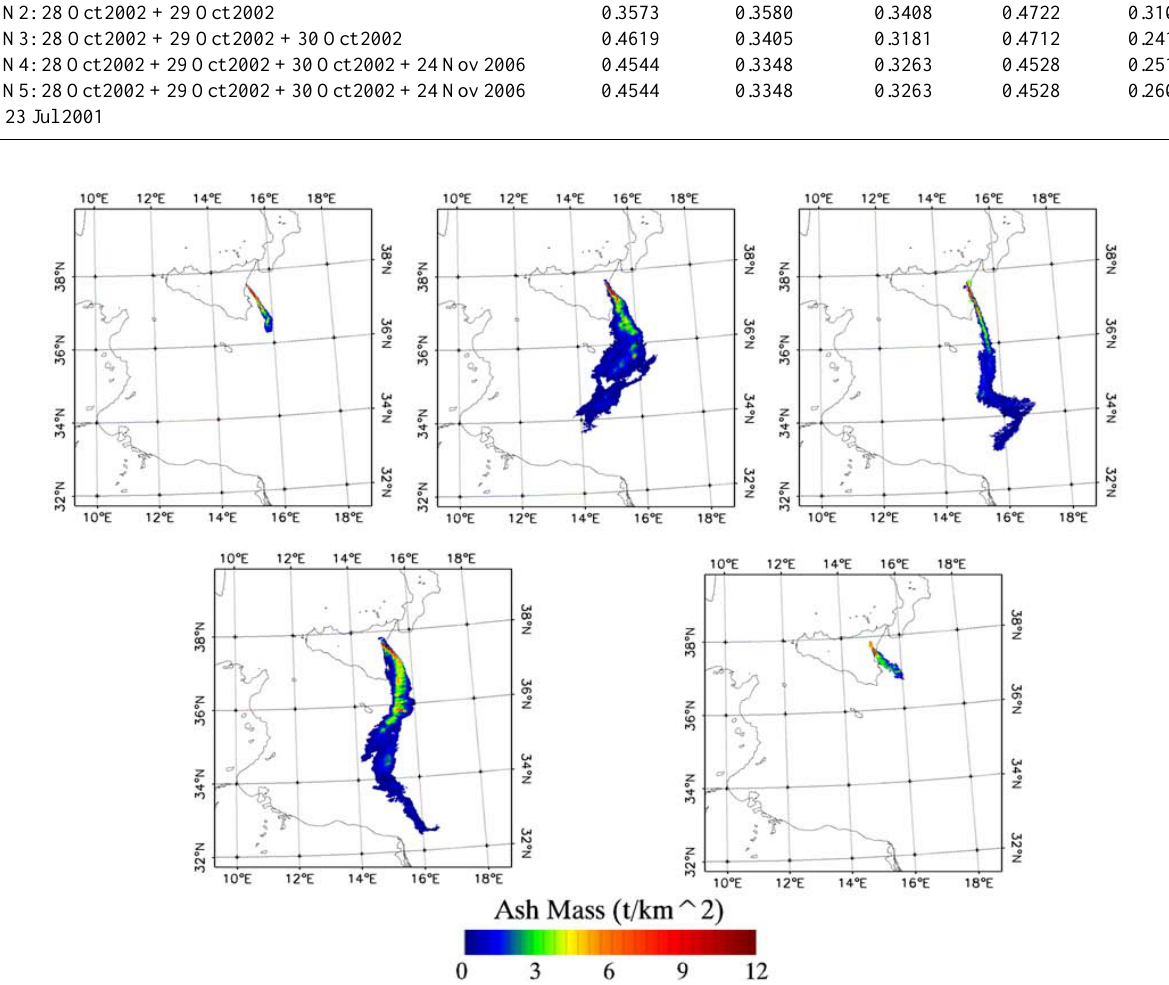
Fig. 7. NNs MODIS Ash mass maps from five different dates. Top Plates, from left to right: 23 July 2001, 28 October 2001 and 29 Octo- ber 2002. Bottom Plates, from left to right: 30 October 2002 and 24 November